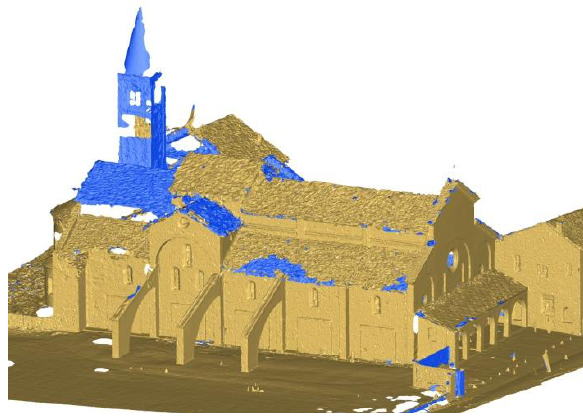
Figure 15. Point cloud extracted using Photoscan software